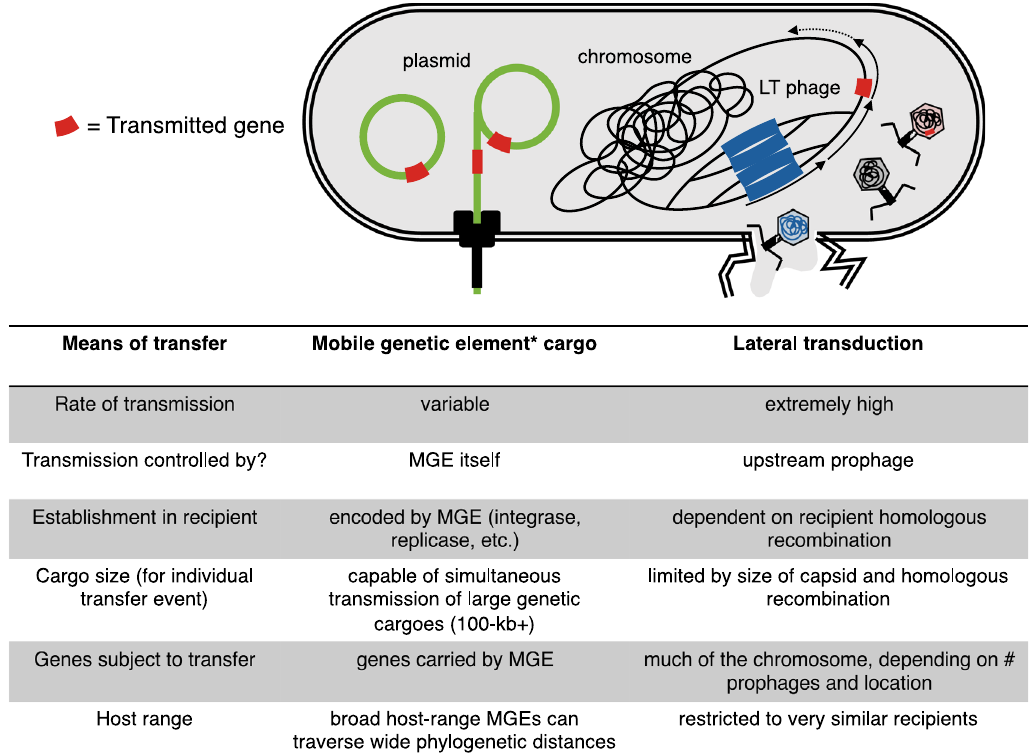
Fig. 1 A comparison of gene transfer by lateral transduction with classical mobile genetic element cargo. *Note: as mobile genetic elements are very diverse, this column shows trends. There are likely to be